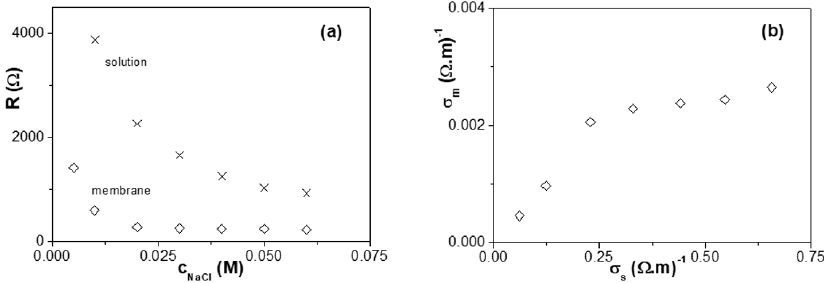
Figure 4. ( a ) Variation of 26% AlqCl/74% CTA membrane ( ◊ ) and NaCl solution (×) electrical resistance with electrolyte concentration. ( b ) Membrane conductivity versus solution (NaCl) conductivity.